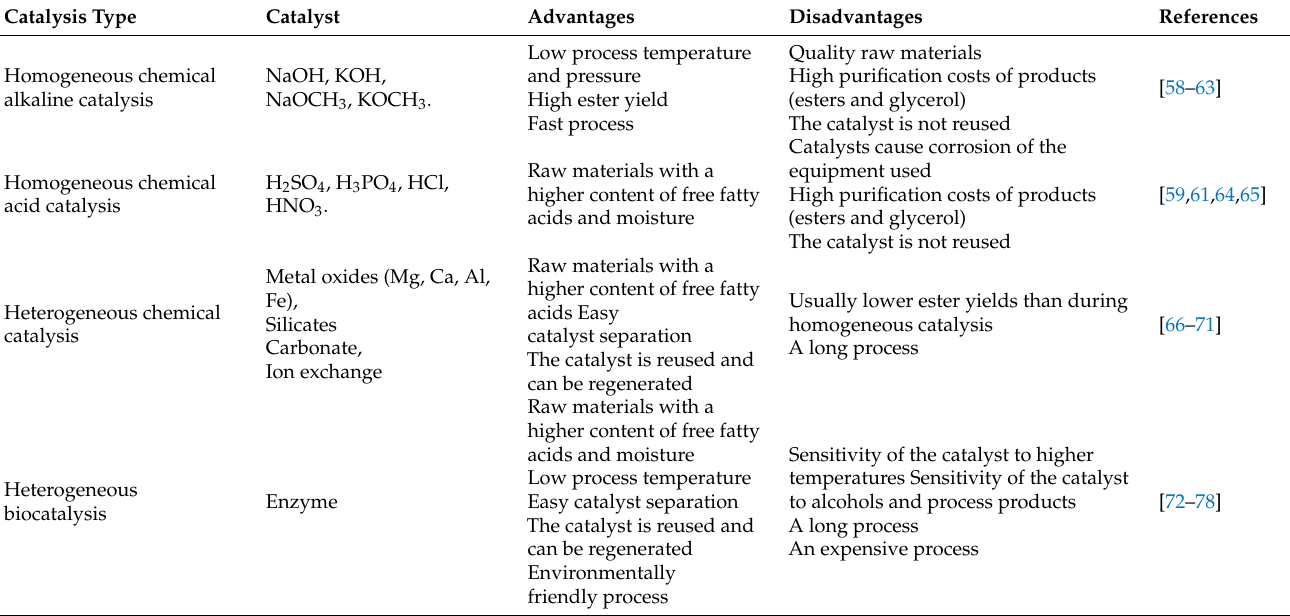
Table 6. Characteristics of different types of catalysts of transesterification of algal